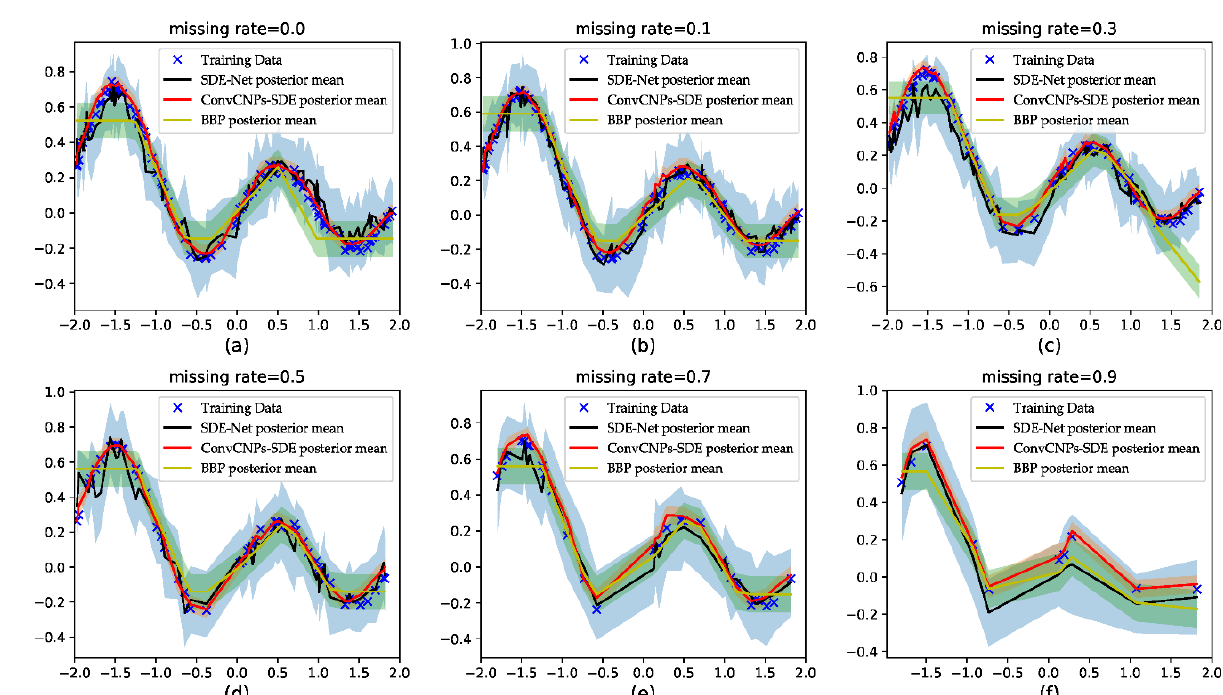
Figure 6. Visualizing the uncertainty of predictive distribution in regression tasks. ( a – f ) show that (1-MR) × 100 training data with MR = [0.0, 0.1, 0.3, 0.5, 0.7, 0.9], respectively, is used to train the SDE-Net, BBP, and the proposed ConvCNPs – SDE-Net.